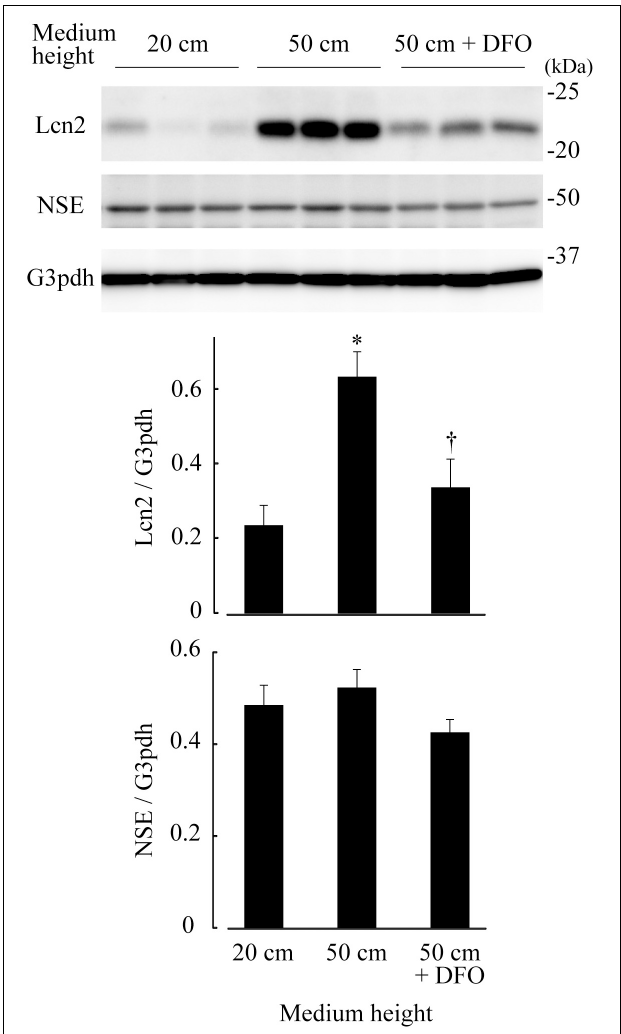
FIGURE 2 | Lipocalin 2 (Lcn2) protein levels in retinae cultured under 20 cm H 2 O, 50 cm H 2 O, and 50 cm H 2 O with deferoxamine (DFO). C57BL/6J mouse retinae were cultured under medium heights of 20 cm and 50 cm, and 50 cm with 100 µ M DFO. After 48 h, retinal tissue extracts were subjected to immunoblotting for Lcn2, neuron-specific enolase (NSE) and glyceraldehyde-3-phosphate dehydrogenase (G3pdh). Graphs represent relative protein levels of Lcn2 and NSE compared to the G3pdh loading control. * p ≤ 0.05 vs. 20 cm, † p ≤ 0.05 vs. 50